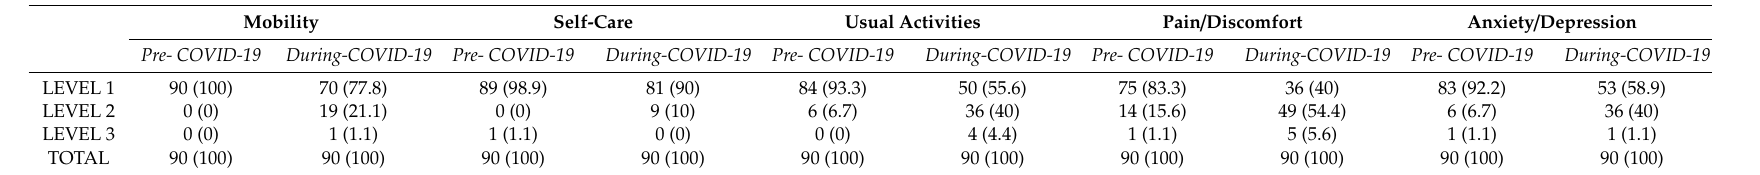
Values are expressed as number and percentage in parenthesis [ n